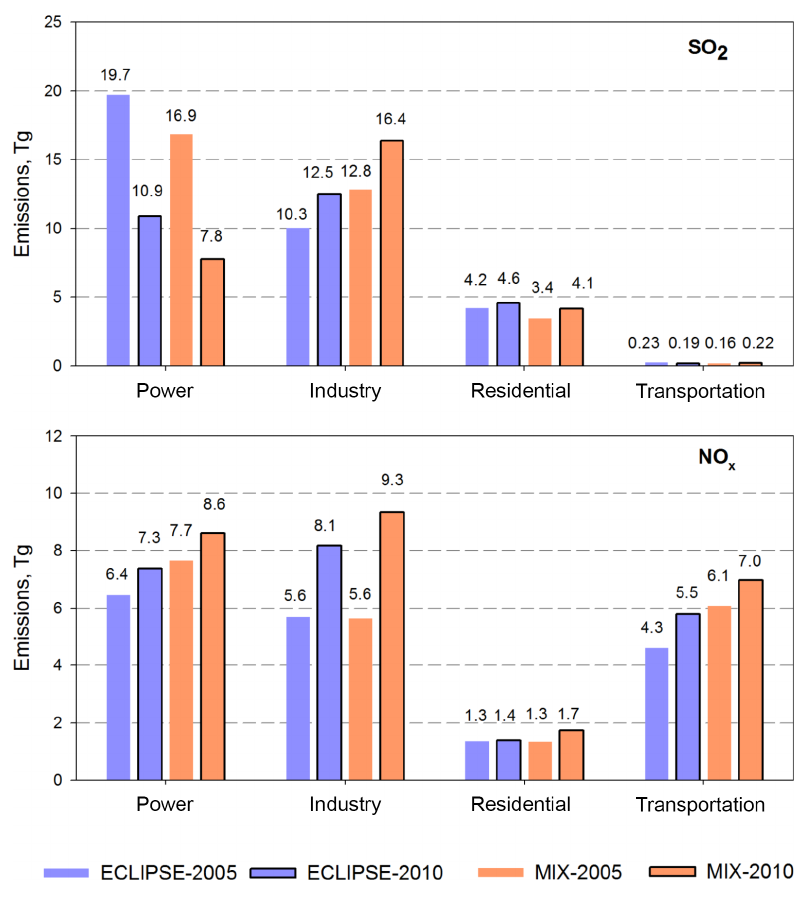
Figure 1. Emissions of SO 2 and NO x in 2005 and 2010 by sector over China. NO x emissions are shown in Tg NO 2 .